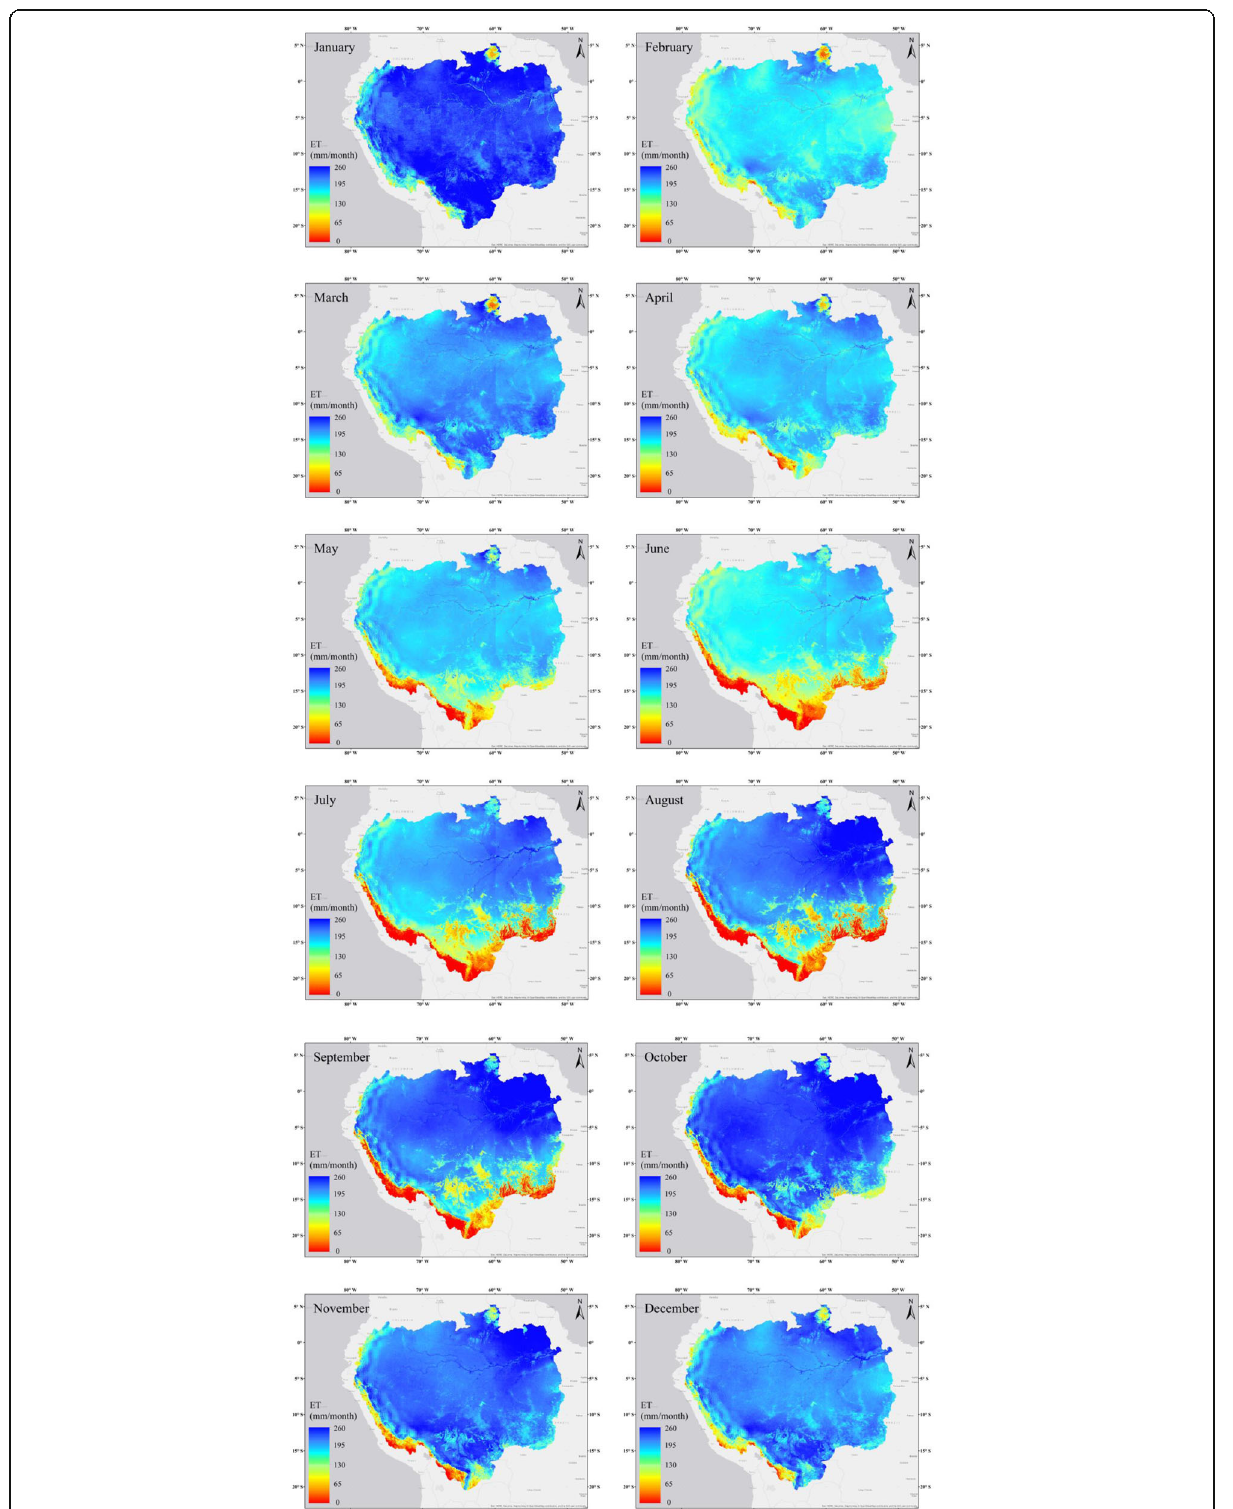
Fig. 9 Monthly ET over the period 2003 to 2013 based on